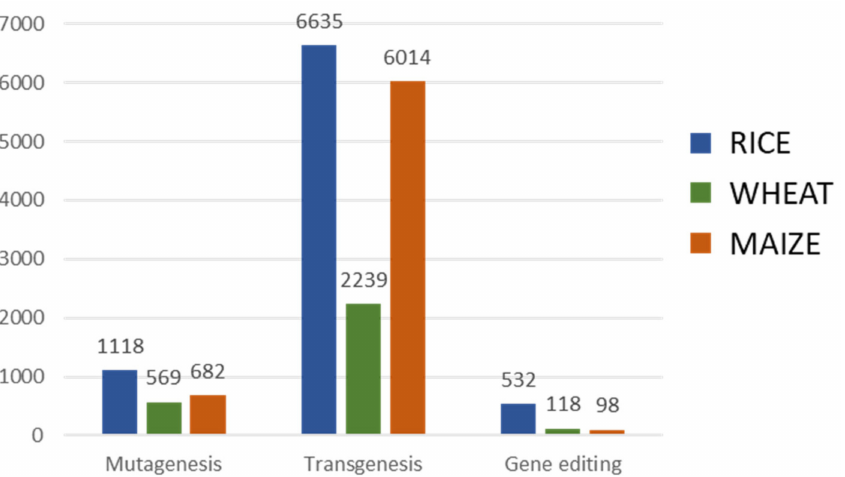
Figure 6. Number of bibliographic records referring to main approaches for genetic modifica- tion in rice, wheat and maize (Source: Web of Science database, all years available; accessed